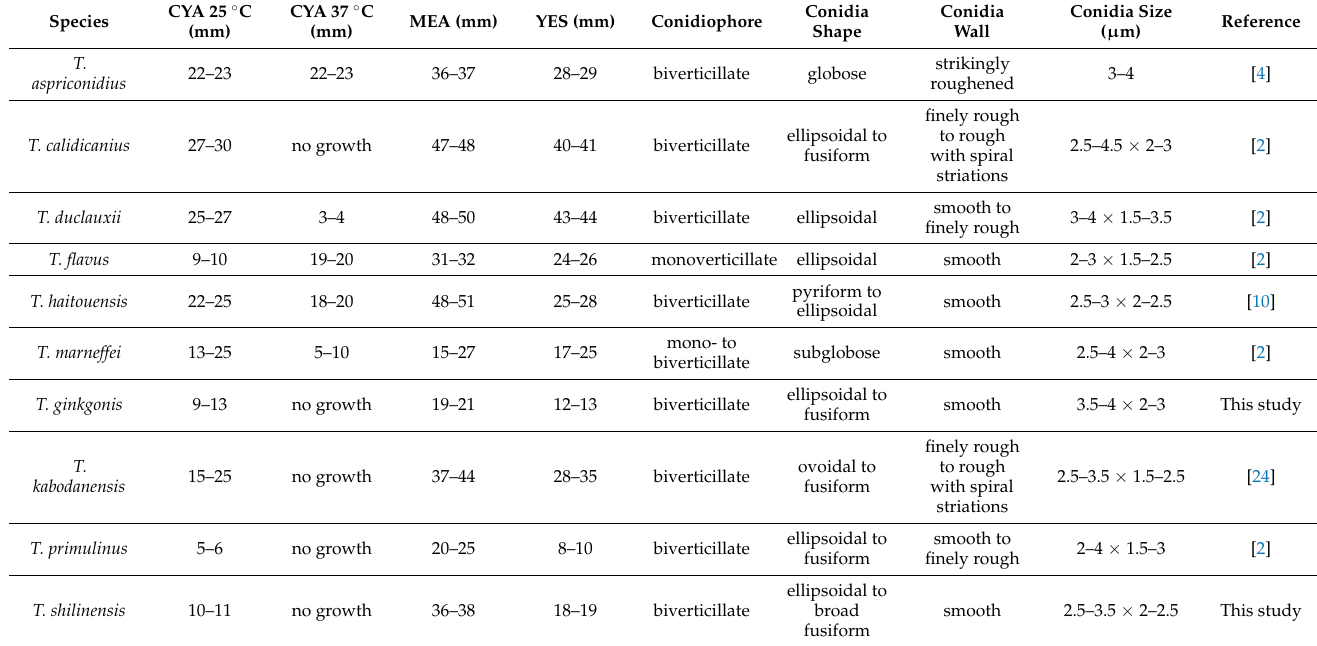
Table 3. Morphological comparisons of new Talaromyces species and their closely related